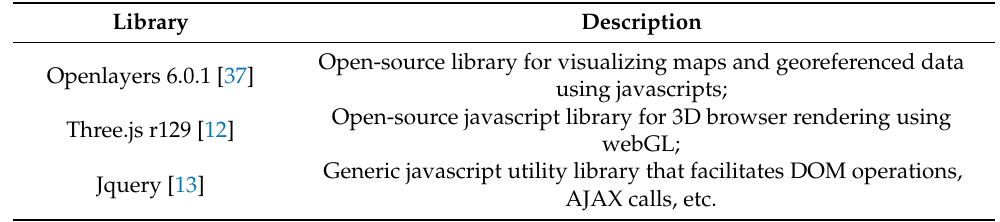
Table 2. Front-end libraries